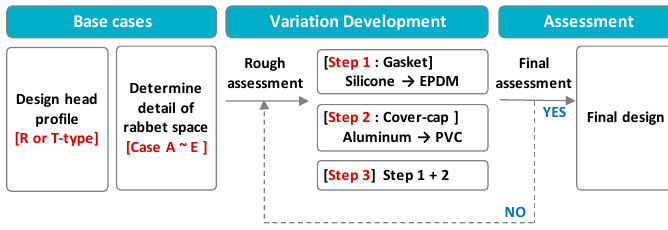
Figure 5. Flowchart of the alternative development process.